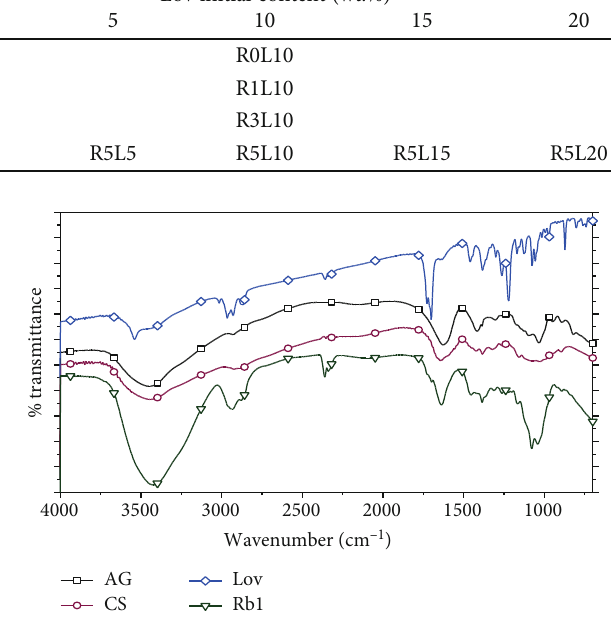
Figure 1: FTIR spectra of AG, CS, Lov, and ginsenoside